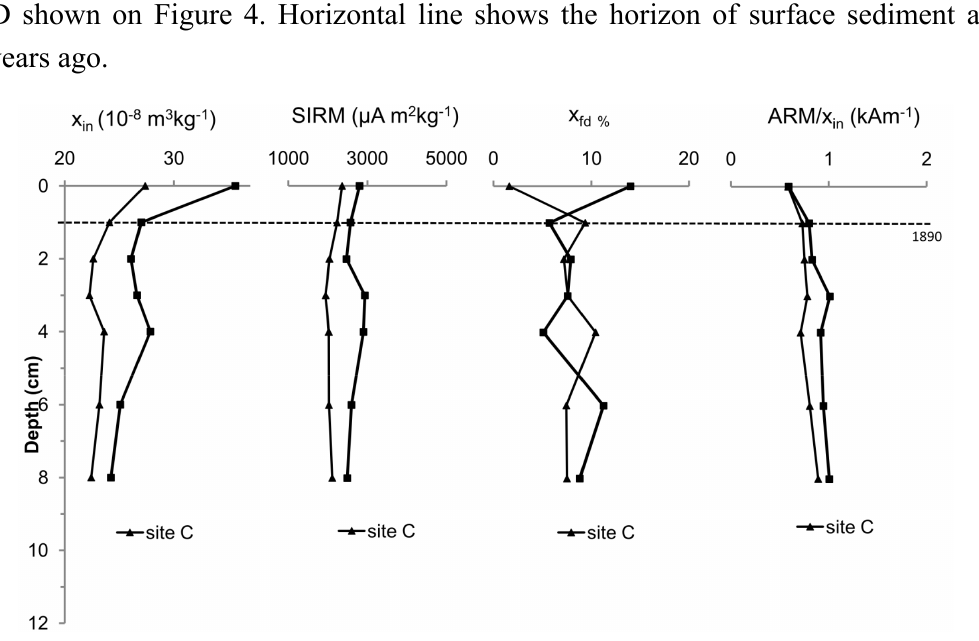
(10 − 8 m 3 ·kg − 1 ), SIRM ( μA m 2 ·kg − 1 ) and χ in